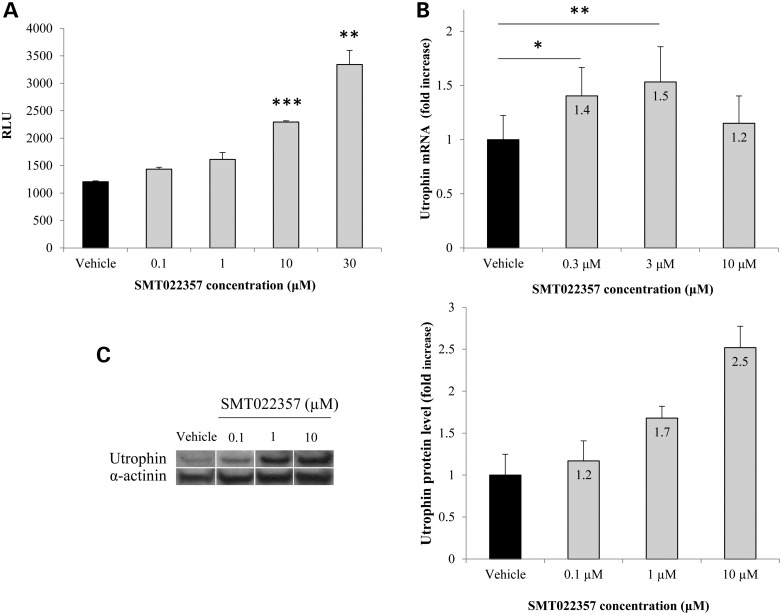
In vitro activity of SMT022357. (A) SMT022357 in vitro dose response in murine H2k-mdx utrnA-luc cells expressing the human utrophin promoter linked to a firefly luciferase reporter gene. Cells were treated with compound for 24 h in standard growth medium containing 1% DMSO. The chart shows relative luminescence (RLU) in relation to five different doses (0.1, 0.3, 1, 3 and 10 µM) of SMT022357. (B) SMT022357 significantly increased mRNA copy number of the utrophin transcript in murine myoblast cells. Cells were exposed to different dose of SMT022357 in standard media with 0.1% DMSO (vehicle) for 24 hours with six biological replicates. Utrophin transcripts were normalised with 18s and b2m. Values are mean ± SEM of n = 6 per condition; *P < 0.05, **P < 0.01, ***P < 0.001. (C) Relative utrophin protein expression in murine cells treated with SMT022357 was determined by western blot and standardized for α-actinin loading. Western blots showing 2.5-fold increase of utrophin protein expression with 10 µM of SMT022357 when compared with vehicle. Relative utrophin expression is shown as mean ± SEM of n = 3 per condition.